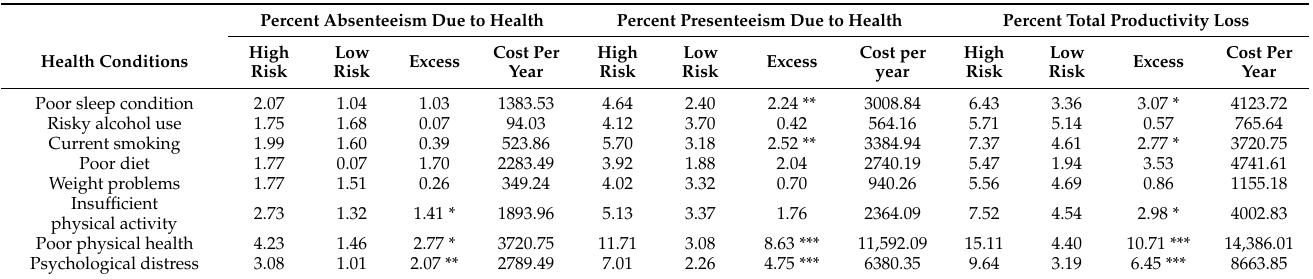
Table 5. Average percentages of absenteeism, presenteeism and total productivity loss and annual excess cost attributed to health risks per worker ( N =